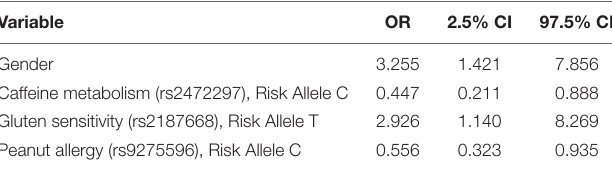
TABLE 2 | Functional gastrointestinal disorders (FGID) vs. non-FGID logistic model: demographics + genomics (D + G).